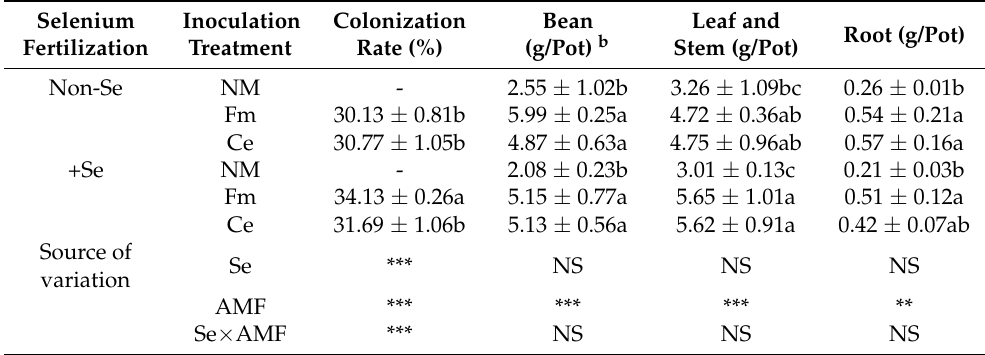
Table 1. Effect of AMF inoculation and Se fertilization on dry weight of soybean individual organs and AMF colonization rates of roots a